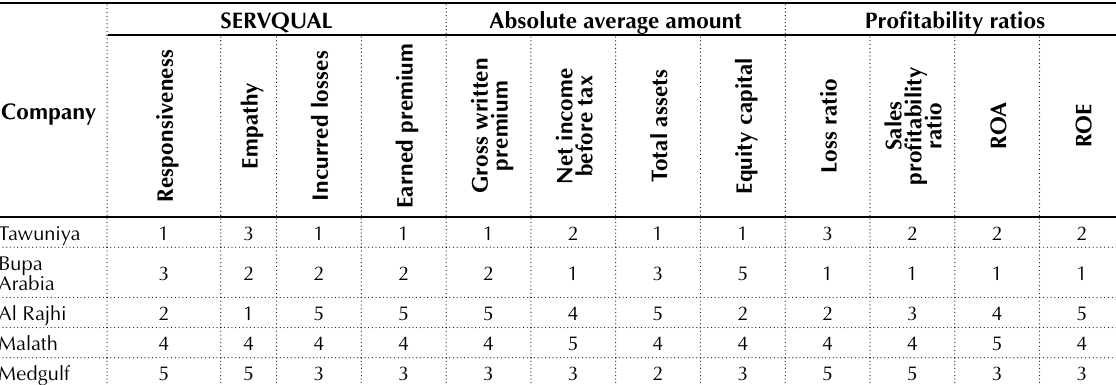
Table 6. Summary – ranking of customer satisfaction, profitability ratios and absolute average